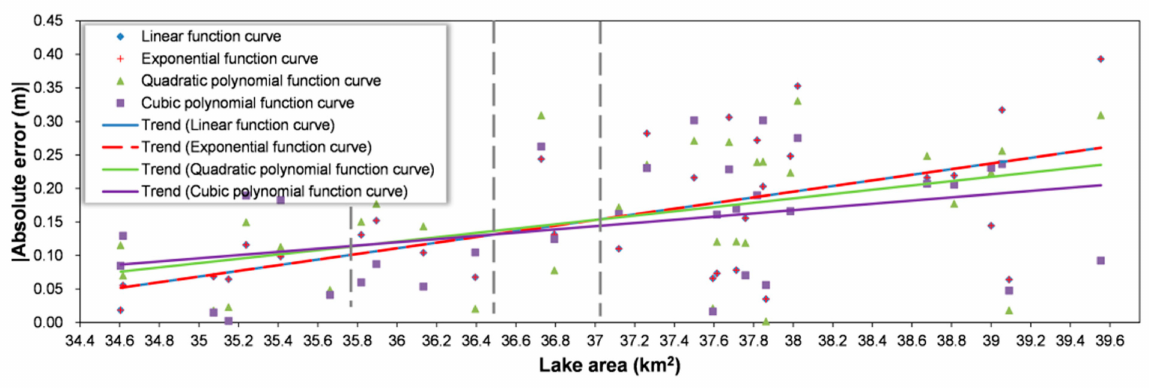
Figure 18. Validation of the accuracy of different hypsographic